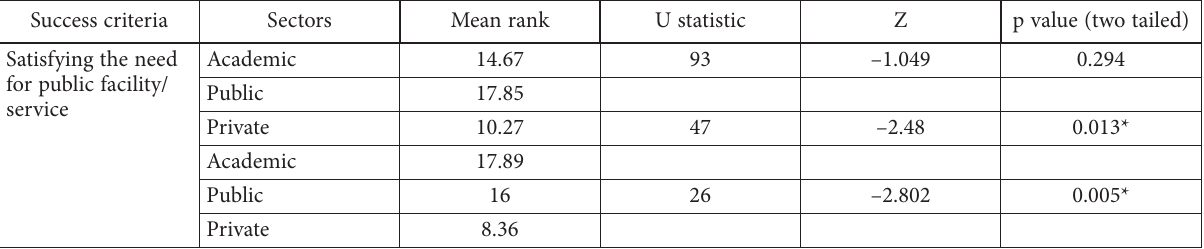
Table 8. Results of Mann Whitney U test on the rankings of success criteria between specific groups of stakeholders Success